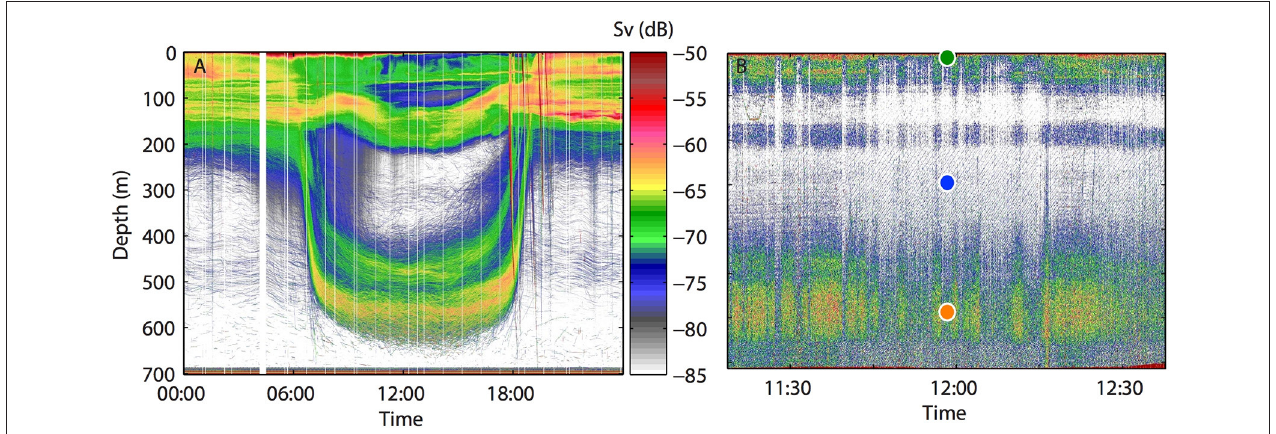
FIGURE 1 | Acoustic data. (A) Typical diel cycle variation in the vertical distribution of migrating organisms from acoustic backscatter in the central Red Sea. Sv (dB) is a proxy for biomass. (B) Daytime uncalibrated echogram section recorded at the time of sampling. Contouring represents the presence (in orange) and absence (in white) of fish biomass. Circles indicate the depths of water samples collected to run the experiments from the three different water layers studied: surface (S, green), intermediate (I, blue) and deep scattering layer (D,